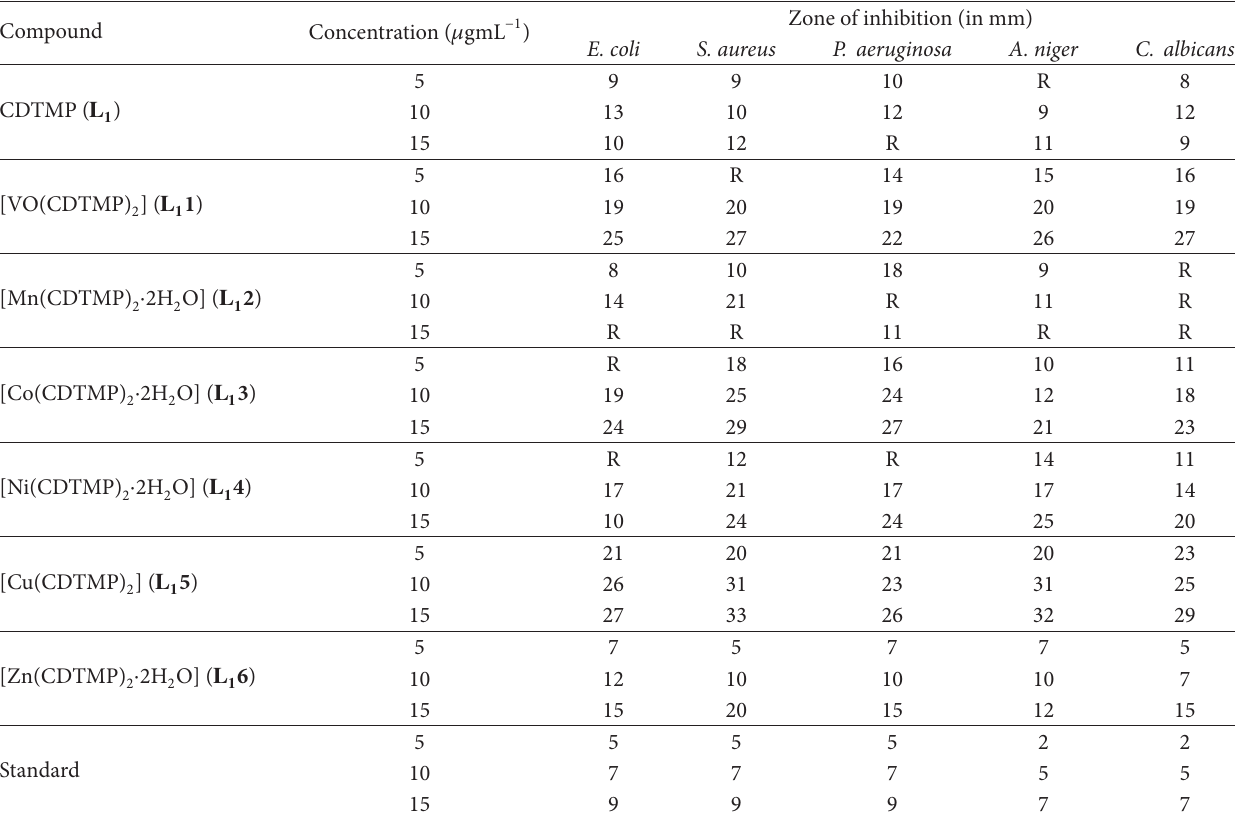
T 8: e in vitro antimicrobial activity of [CDTMP] and its metal(II) complexes